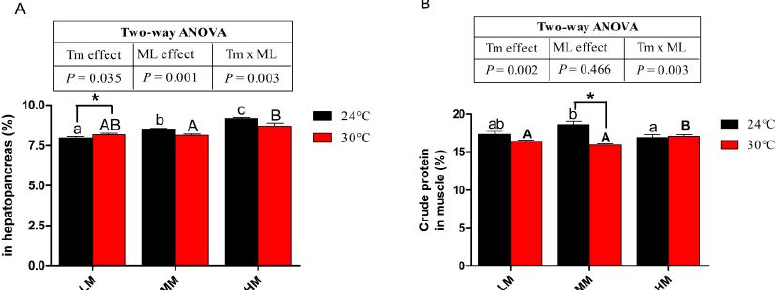
Figure 3. The crude protein content in hepatopancreas ( A ) and the crude protein in muscle ( B ) of juvenile E. sinensis fed the experimental diets at normal (24 ◦ C)/high water temperature (30 ◦ C). * means that there is a significant difference between different temperatures at the same dietary methionine level ( p < 0.05). The a, b and c indicate significant differences among crabs fed diets with different dietary methionine levels at normal temperature ( p < 0.05). The A and B indicate significant differences among crabs fed diets with different dietary methionine levels at high water temperature ( p < 0.05).